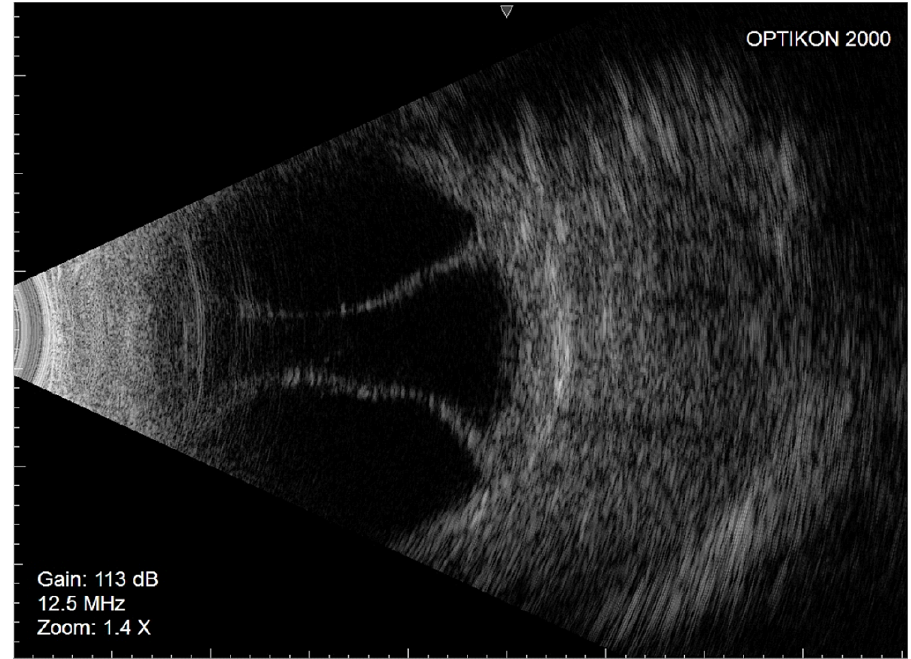
Figure 2. Right eye Eco-B scan showing serous choroidal detachment.